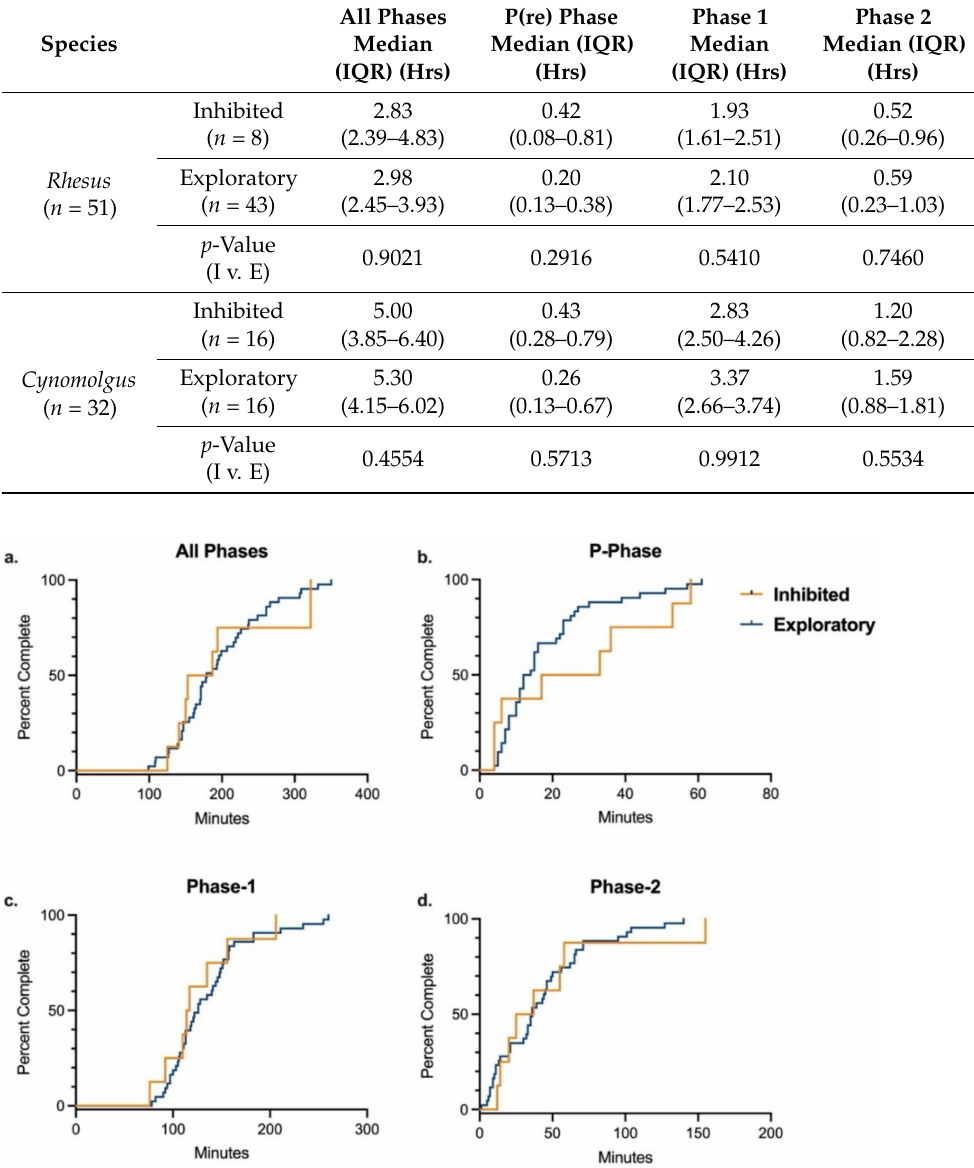
Table 4. Training Time Summary by Temperament.